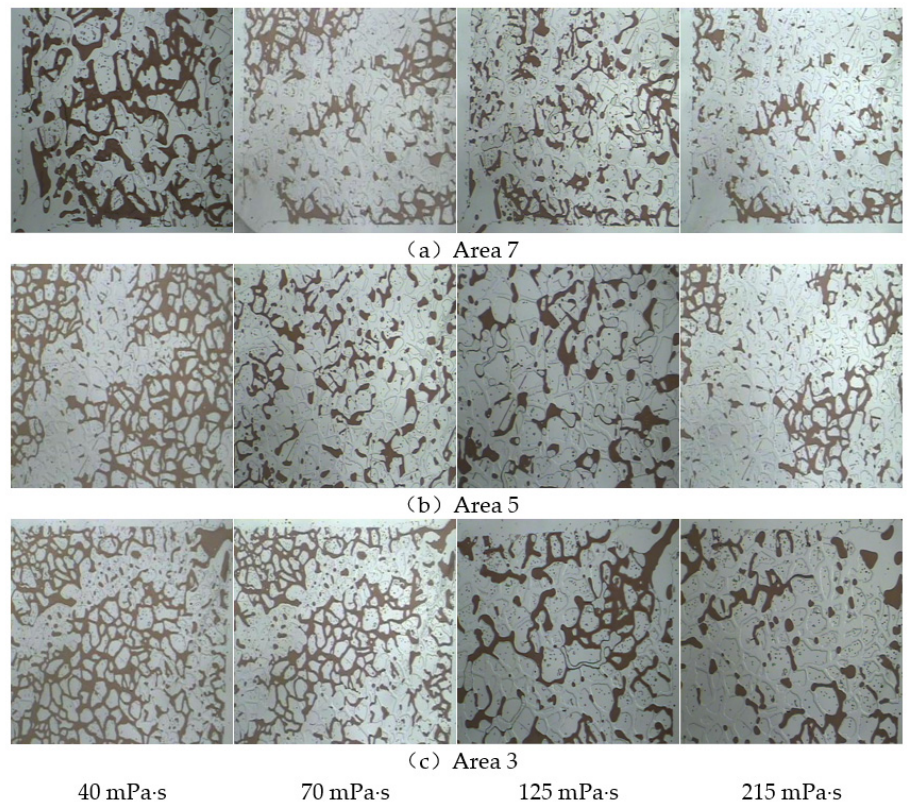
Figure 12. Microscopic remaining oil production in the mainstream area under different viscosity conditions. ( a ) Area 7. ( b ) Area 5. ( c ) Area 3. Table 3. Changes in recovery factors in different areas of the mainstream